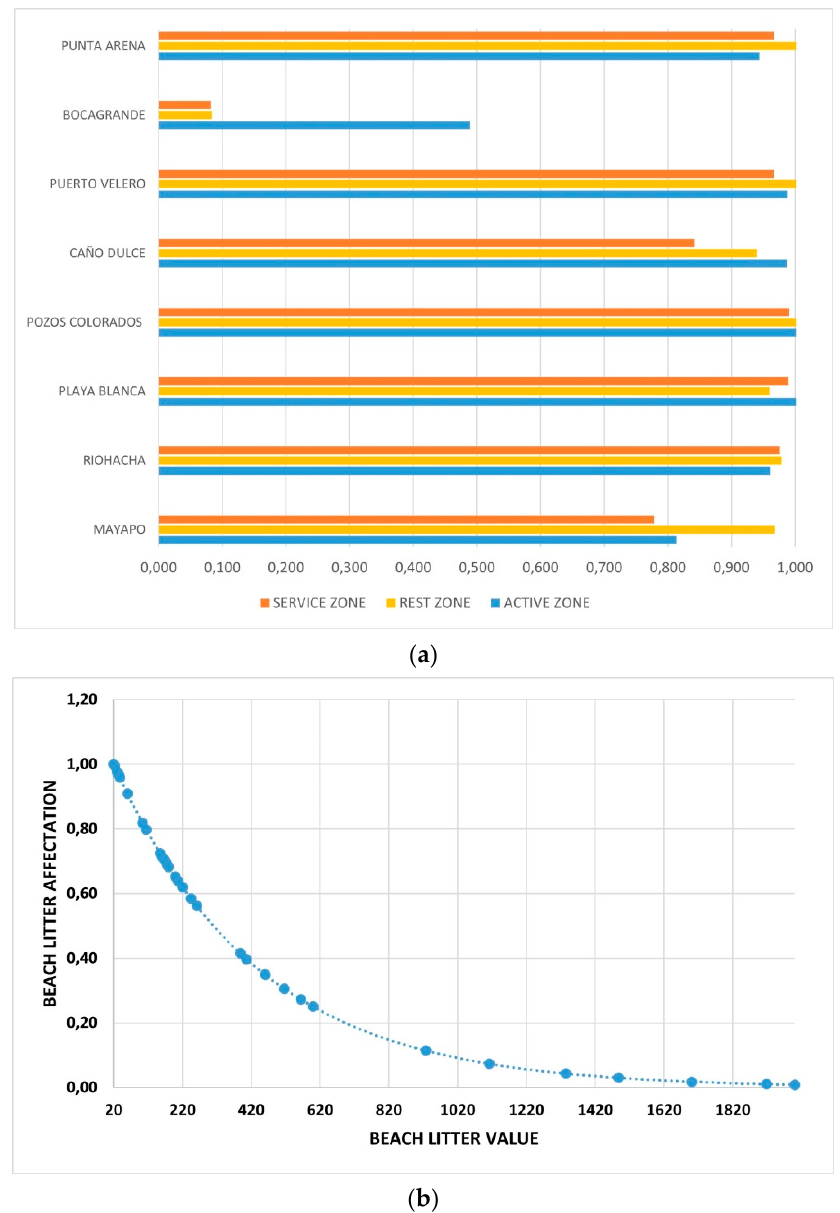
Figure 6. Application of the quantitative results of the BLAT-QQ technique in eight Colombian beaches ( a ). beach litter cleanliness in the three stripes of each beach; ( b ). mathematical function of BLAT-QQ calculation).